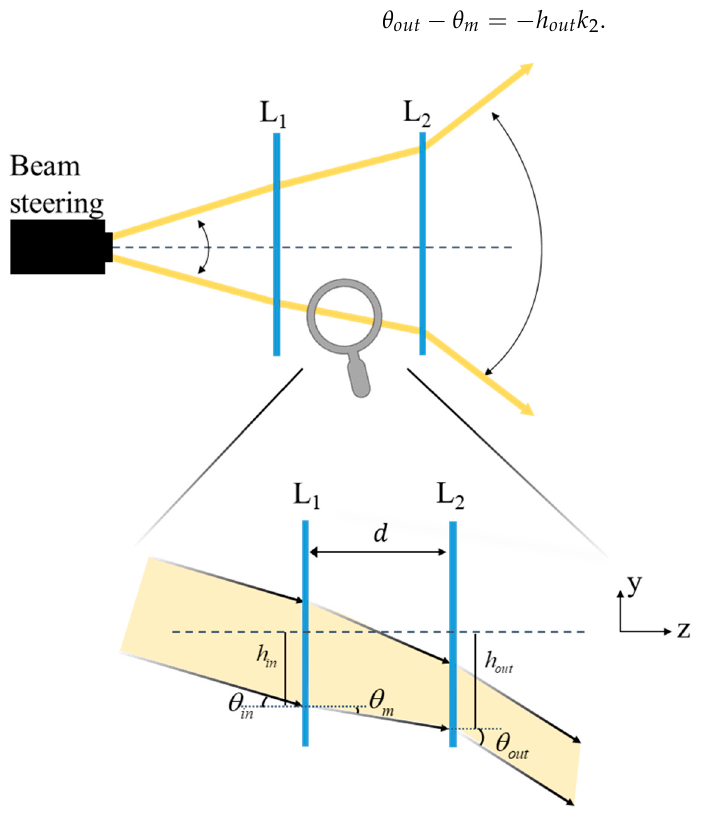
Figure 1. Schematic illustration of the BAE consisting of two PB lenses. The magnified part is a detailed ray-tracing process for one beam, as an example.